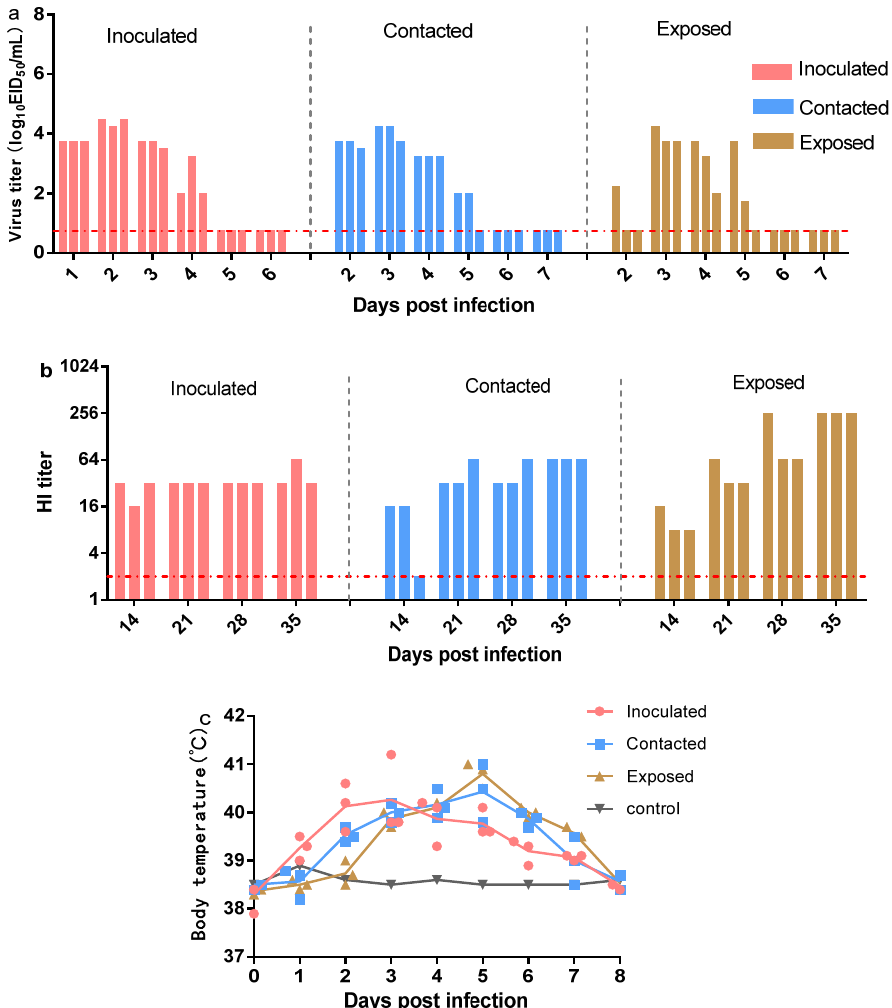
Figure 3. Transmission of canine H3N2 CIVs in beagles. ( a ) The vertical axis represents the titers of influenza viruses recovered from nasal washes of virus-inoculated, contacted, and exposed dogs. The dashed line represents the limit of detection. ( b ) HI antibody titers of the tested animals. Each column represents an individual animal. The dashed line represents the limit of detection. ( c ) Changes in body temperature after canine H3N2